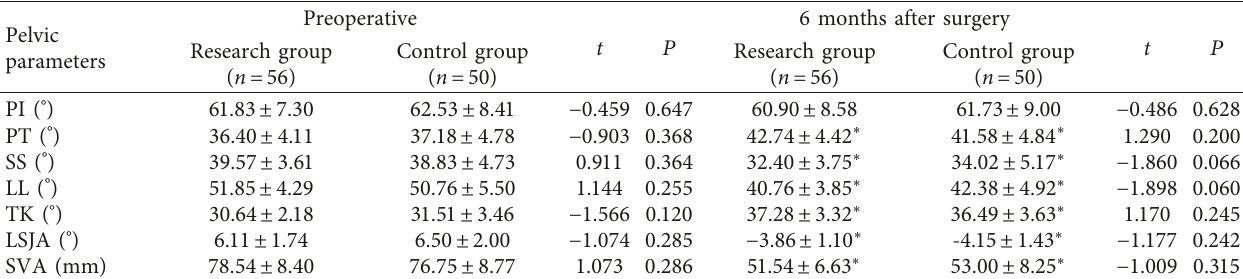
Table 5: Comparison of spine and pelvic parameters between the two groups (x ( ) ± s ).